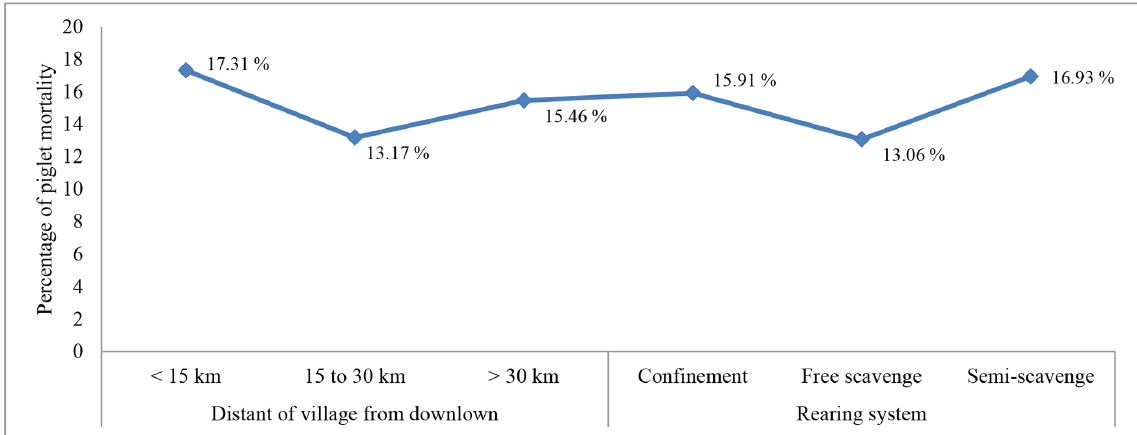
Figure 3. Comparison of piglet mortality based on village clusters and rearing systems. Table 4. Correlation coefficients among reproductive traits of indigenous pigs in northern Laos.